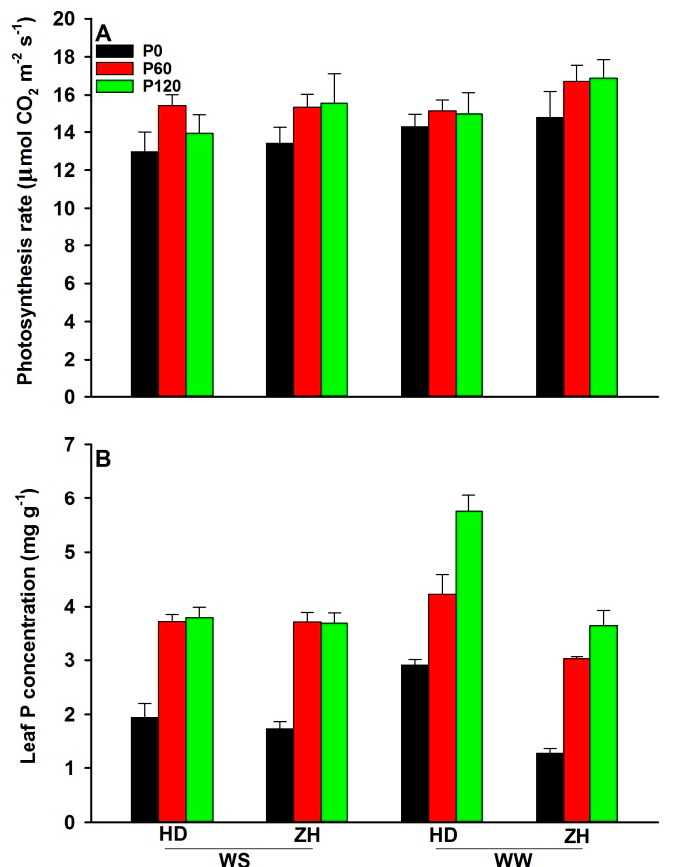
Figure 2. ( A ) Leaf photosynthetic rate at 50 days after sowing (DAS) and ( B ) leaf P concentration at 65 DAS of soybean genotypes Huangsedadou (HD) and Zhonghuang 30 (ZH) with three levels of applied P (0 (P0), 60 (P60) and 120 (P120) mg P kg − 1 dry soil) and two water treatments (well-watered (WW) and cyclic water stress (WS)). Note the leaf photosynthetic rate was measured one day after re-watering. Values are means + one standard error of the mean ( n = 3).